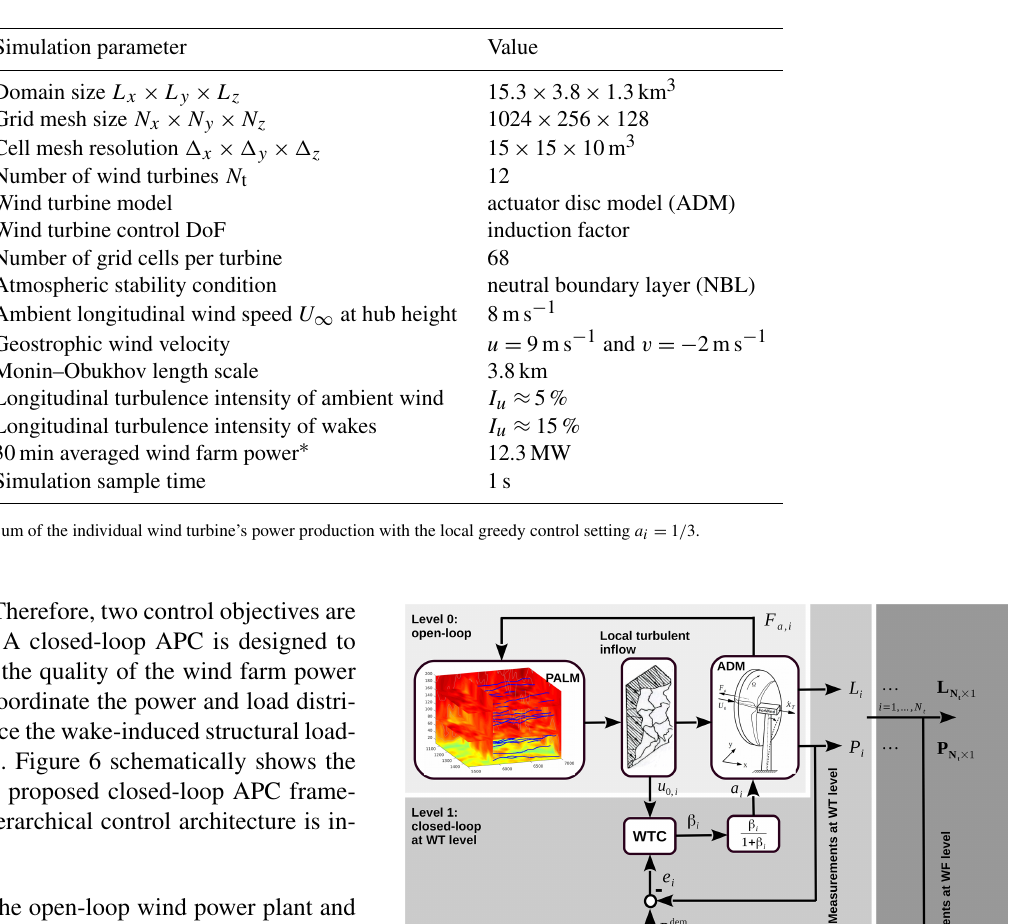
Table 2. The key parameters of the PALM simulation setup.